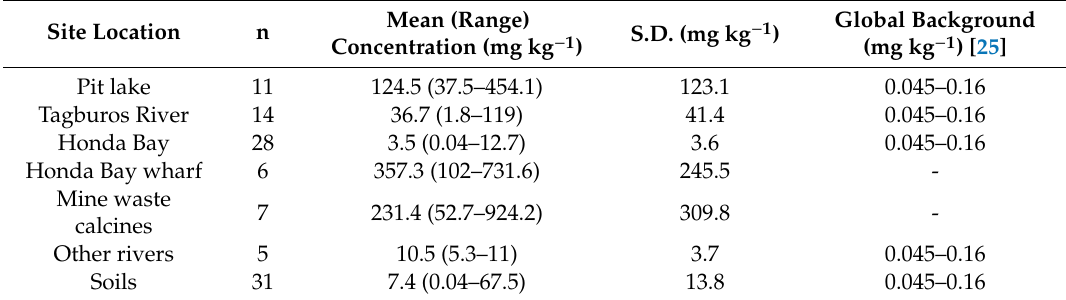
Table 2. Mean total Hg concentration of di ff erent soil and sediment samples collected from di ff erent